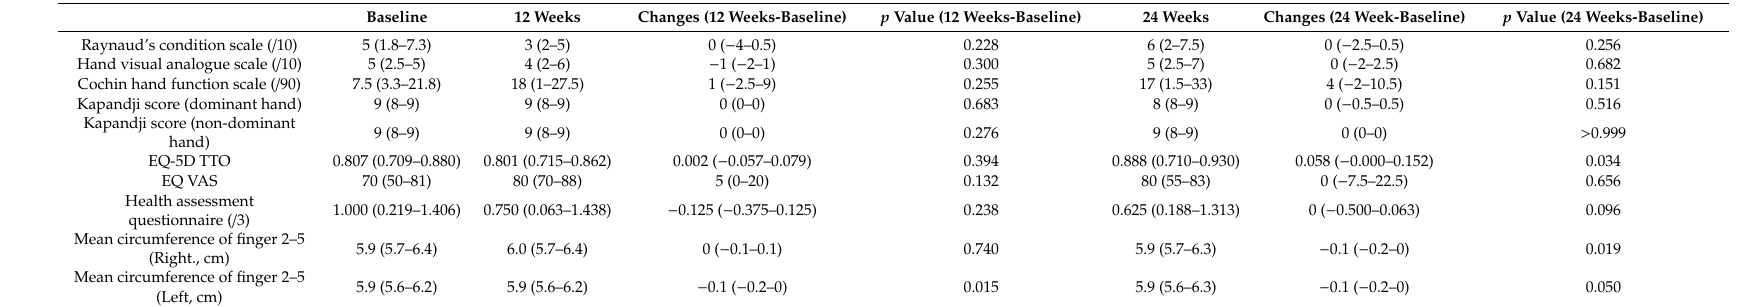
Table 4. Changes of patient-reported indices, hand function, and quality of life (12 weeks, 24 weeks).